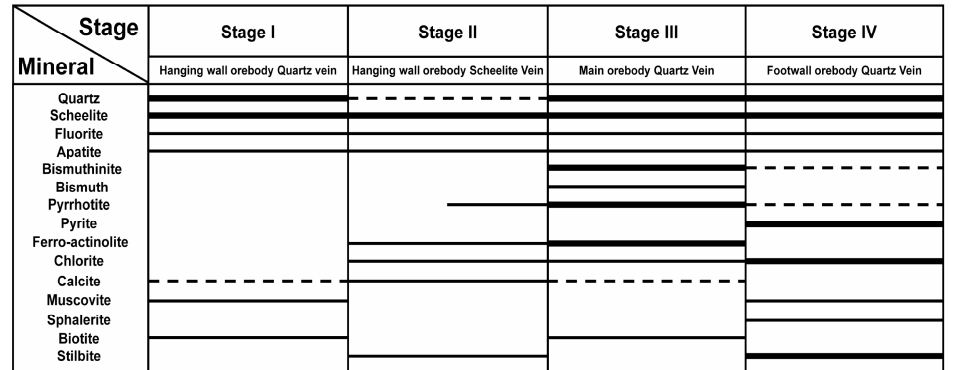
Figure 2. Schematic diagram of mineral paragenesis of Sangdong W-deposit. Bold lines show major paragenetic minerals of the veins, solid lines are minor minerals of each stage, and dashed lines are accessory minerals.